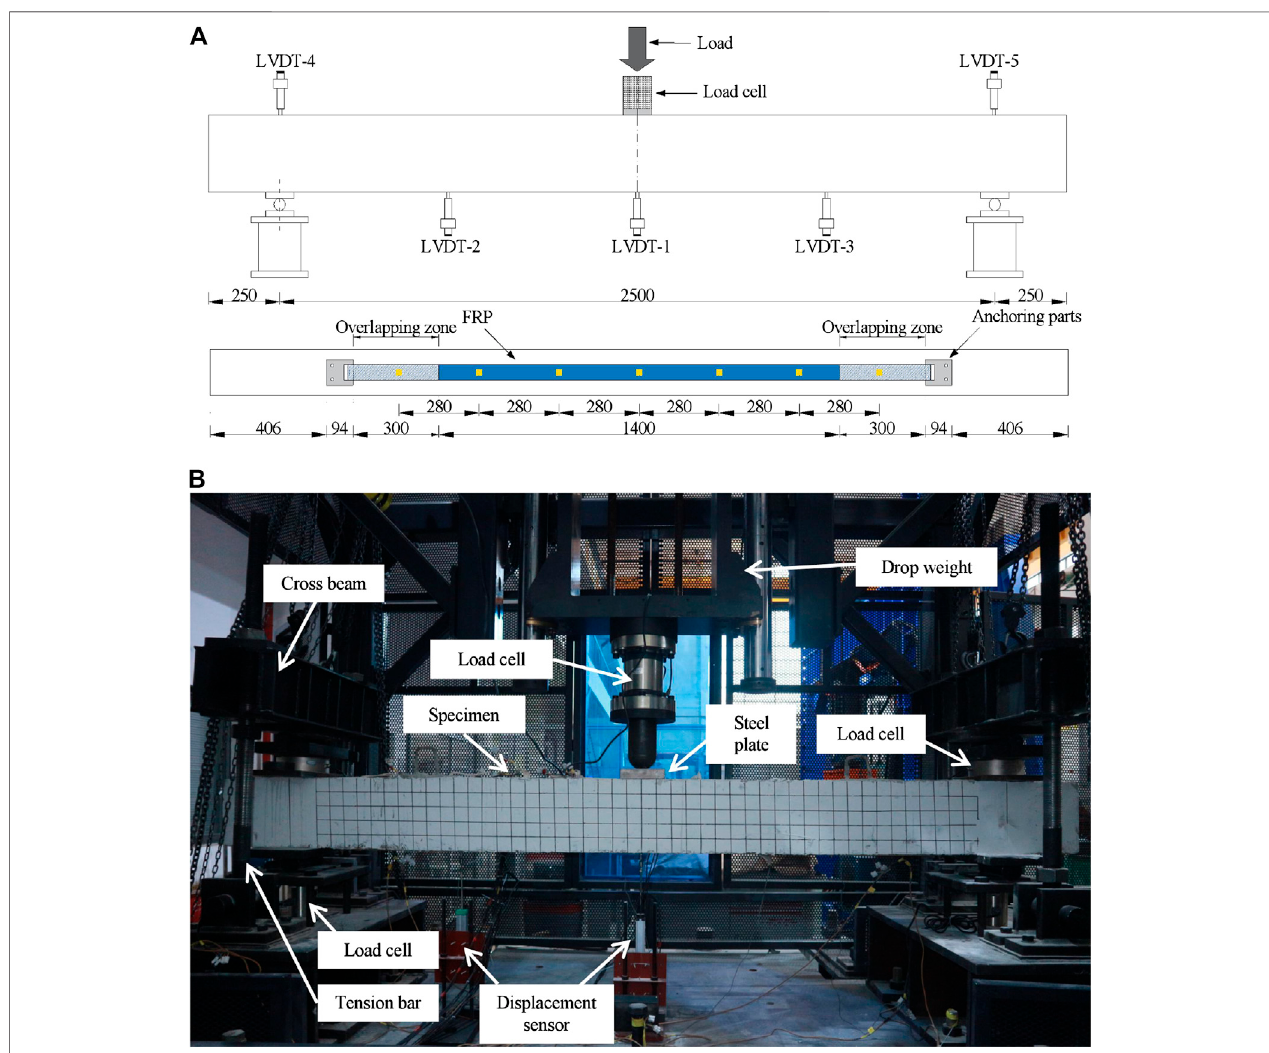
FIGURE 3 | Experimental setup. (A) Static loading test. (B) Impact loading